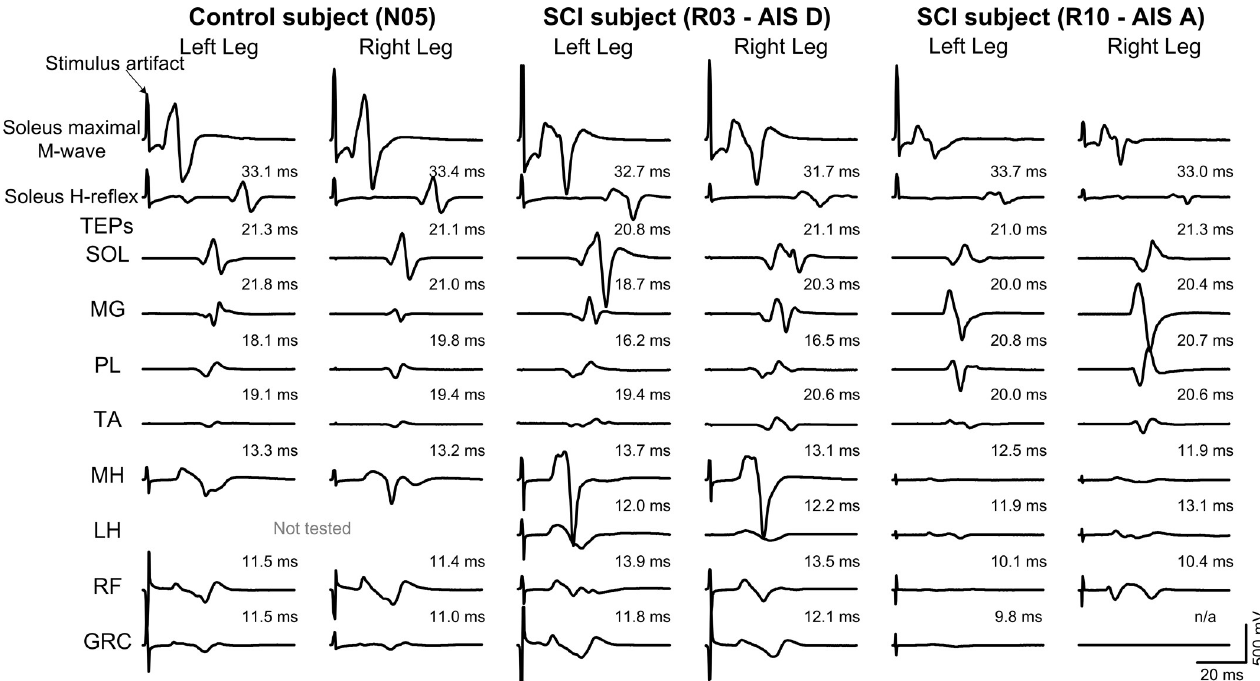
Fig 1. Transspinal evoked potentials (TEPs) in individuals with and without spinal cord injury (SCI). Non-rectified TEP waveform averages recorded (N = 15, elicited at 0.2 Hz) bilaterally from ankle and knee muscles (solid black lines) in a healthy control participant (N-005) and two individuals with SCI presenting with American Spinal Injury Association Impairment Scale (AIS) D (R-003) and AIS A (R-010), respectively. Latencies of the soleus (SOL) maximal M-wave and H-reflex (dashed lines) along with all TEPs across individuals are also presented. MG: medial gastrocnemius; PL: peroneus longus; TA: tibialis anterior; MH: medial hamstring; LH: lateral hamstring; RF: rectus femoris; GRC: gracilis.